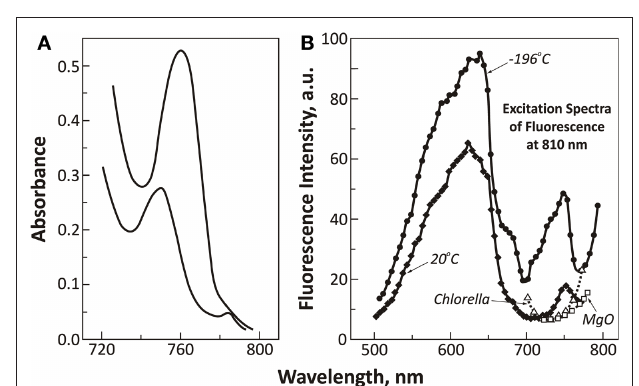
FIgurE 5 | Spectroscopic data on P750 in Anacystis nidulans. (A) Absorbance spectra of two different concentrations of suspensions of A. nidulans cells showing the presence of a band in the 750–760 nm range (called P750; modified and reproduced from Govindjee et al., 1961). (B) Excitation spectra of fluorescence of P750 (measured at its red-most end, at 810 nm) of A. nidulans at 77 K ( − 196 ° C) and at 293 K (20 ° C). A portion of excitation spectrum of the green alga Chlorella is reproduced (open triangles) to show the absence of the excitation band at 750 nm. A curve for MgO is shown (open squares) to point out that the rising part of the curve beyond 760 nm is an artifact due to scattering (reproduced from Govindjee, 1963b).